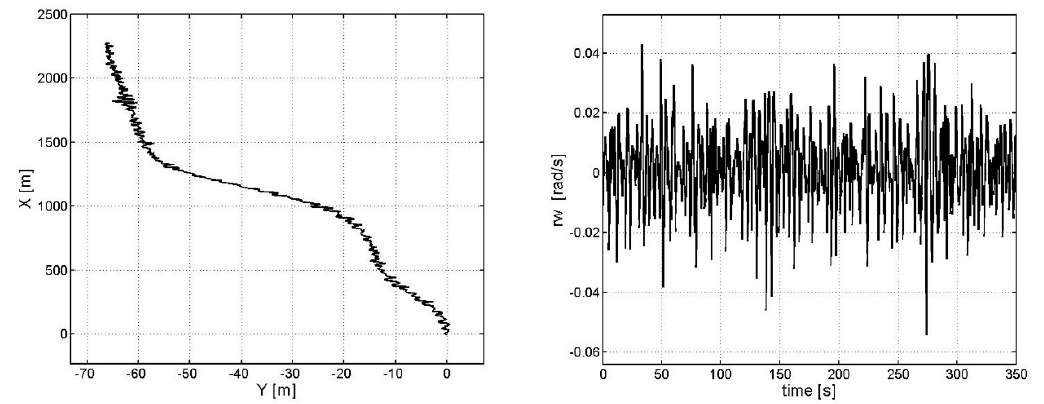
Figure 4. The trajectory of ship movement and signal of angular speed disturbance r w for sea state 4 and the wave angle −π /4.